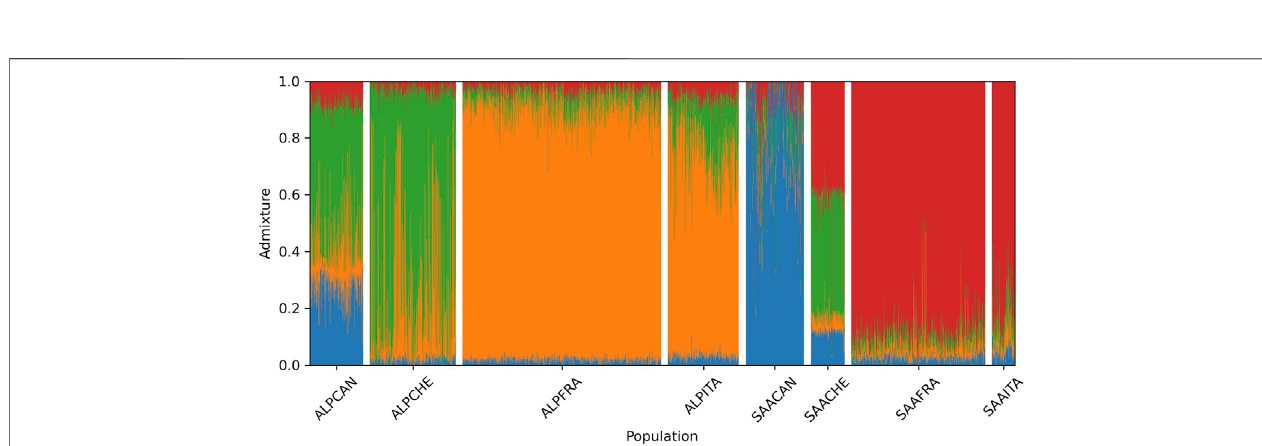
FIGURE 5 | Breed composition per animal for each breed-country population estimated by the Admixture software when considering k = 4 (ALP, Alpine; SAA, Saanen; CAN, Canada; FRA, France; ITA, Italy; CHE, Switzerland).